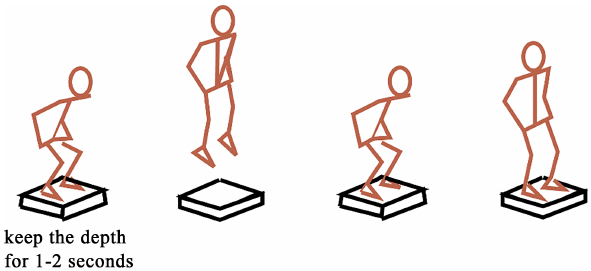
Fig. 1. Diagram of squat jump.